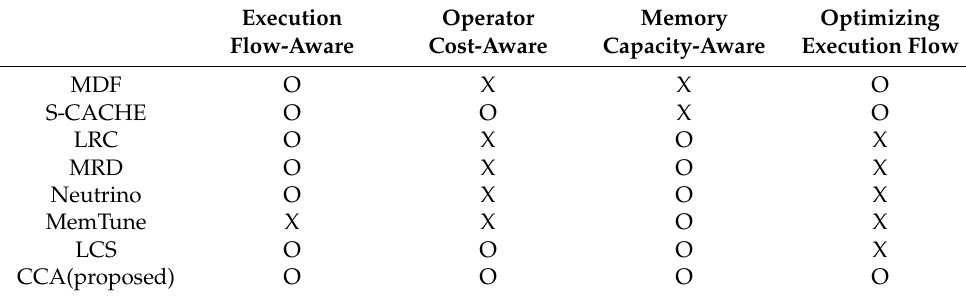
Table 4. Comparison between CCA and related